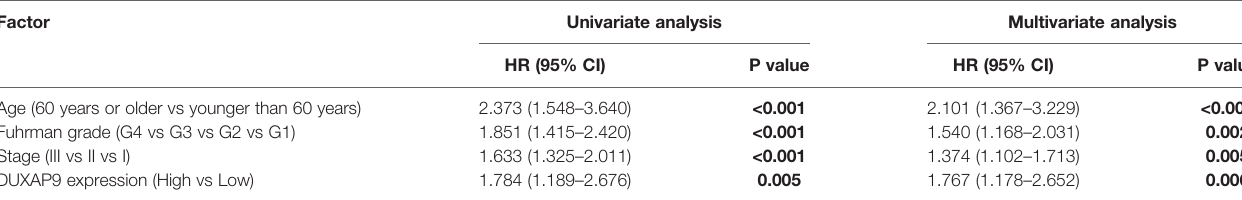
TABLE 2 | Univariate and multivariate analyses of factors predicting overall survival among localized ccRCC cases from TCGA.